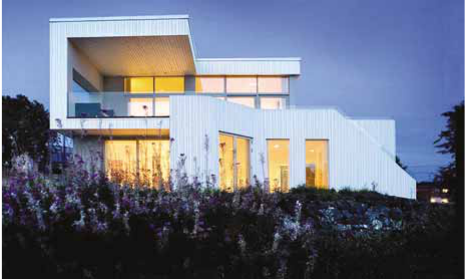
Fig. 10. Kindergarten building in Oslo, Norway, archit. Fig. 8. House – vila “G”, Bergen, Norway, archit.